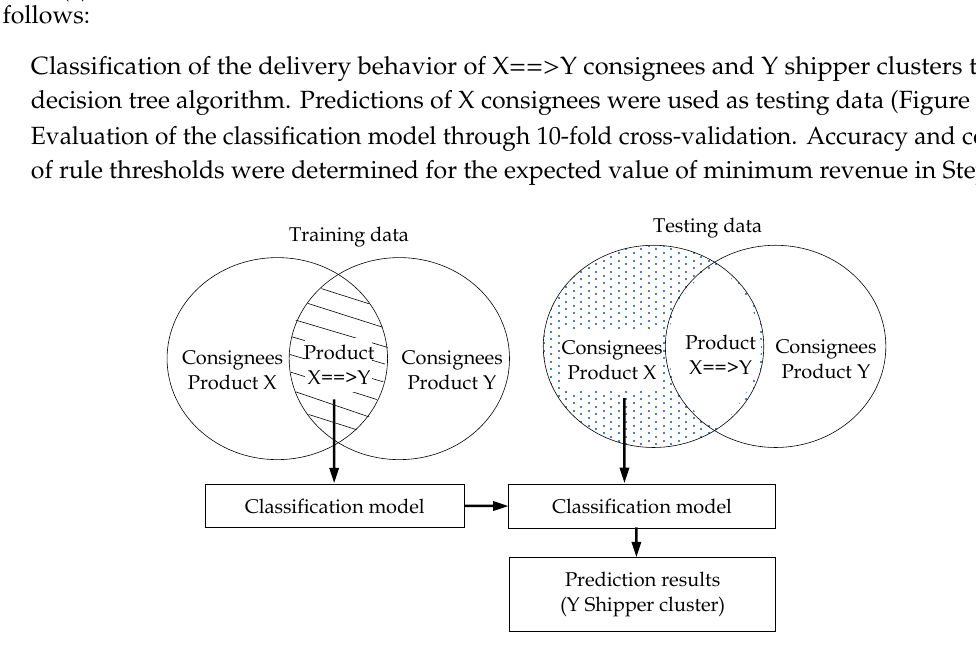
Figure 2. Training and testing data for decision tree learning.